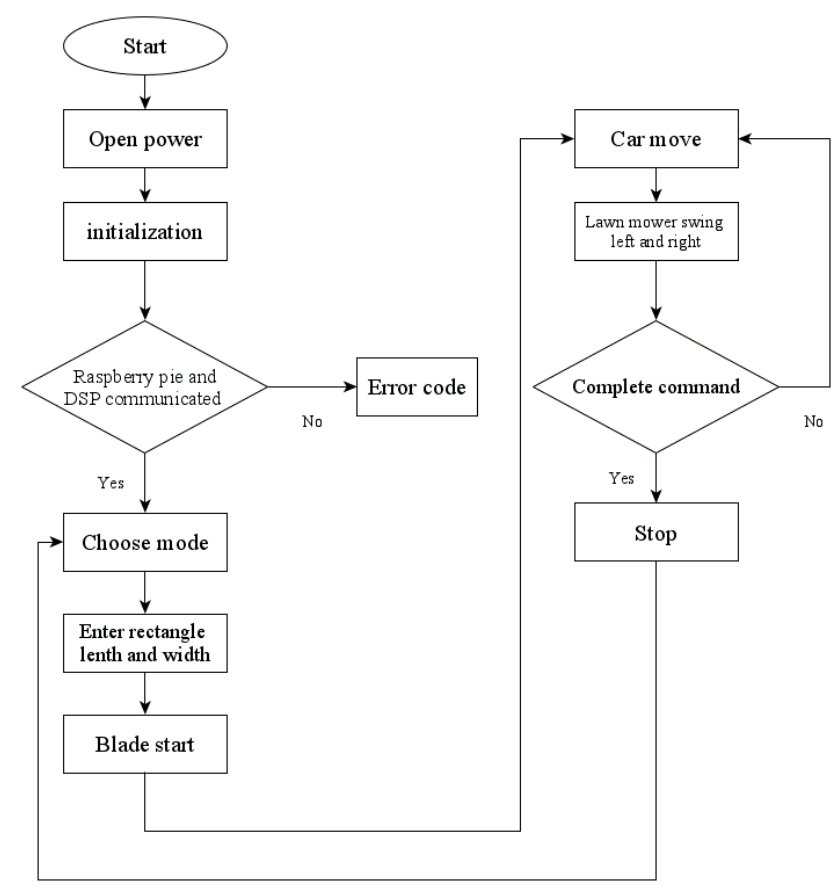
Figure 14. Control process of an automatic robotic lawn mower.